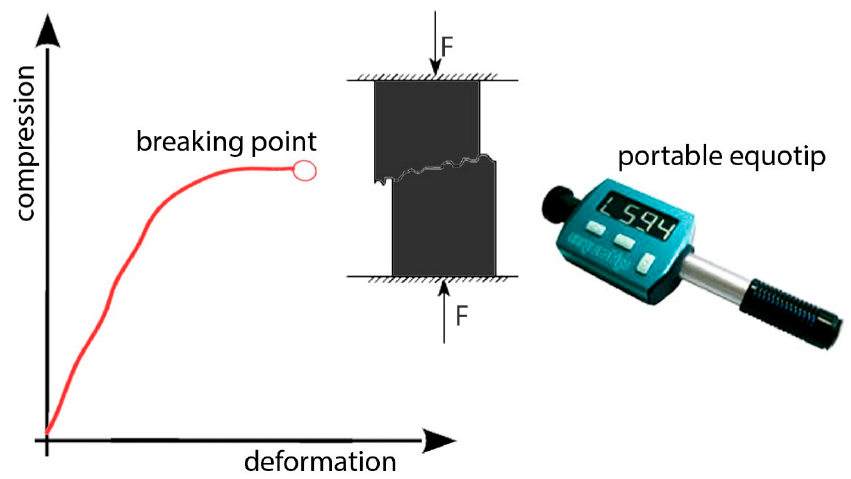
Figure 14. Low ‐ intensity compressive test measures required for the calibration of Equotip L values. After sensor calibration, it is possible to proceed with the validation test under stress conditions (changing moisture levels) for the colonized sample; slices of progressive thicknesses are tested in order to evaluate the magnitude order and the maximum depth penetration of the forces acting on the colonized surface, which are necessary to interpolate a mean surface deformation value (Figure 15).